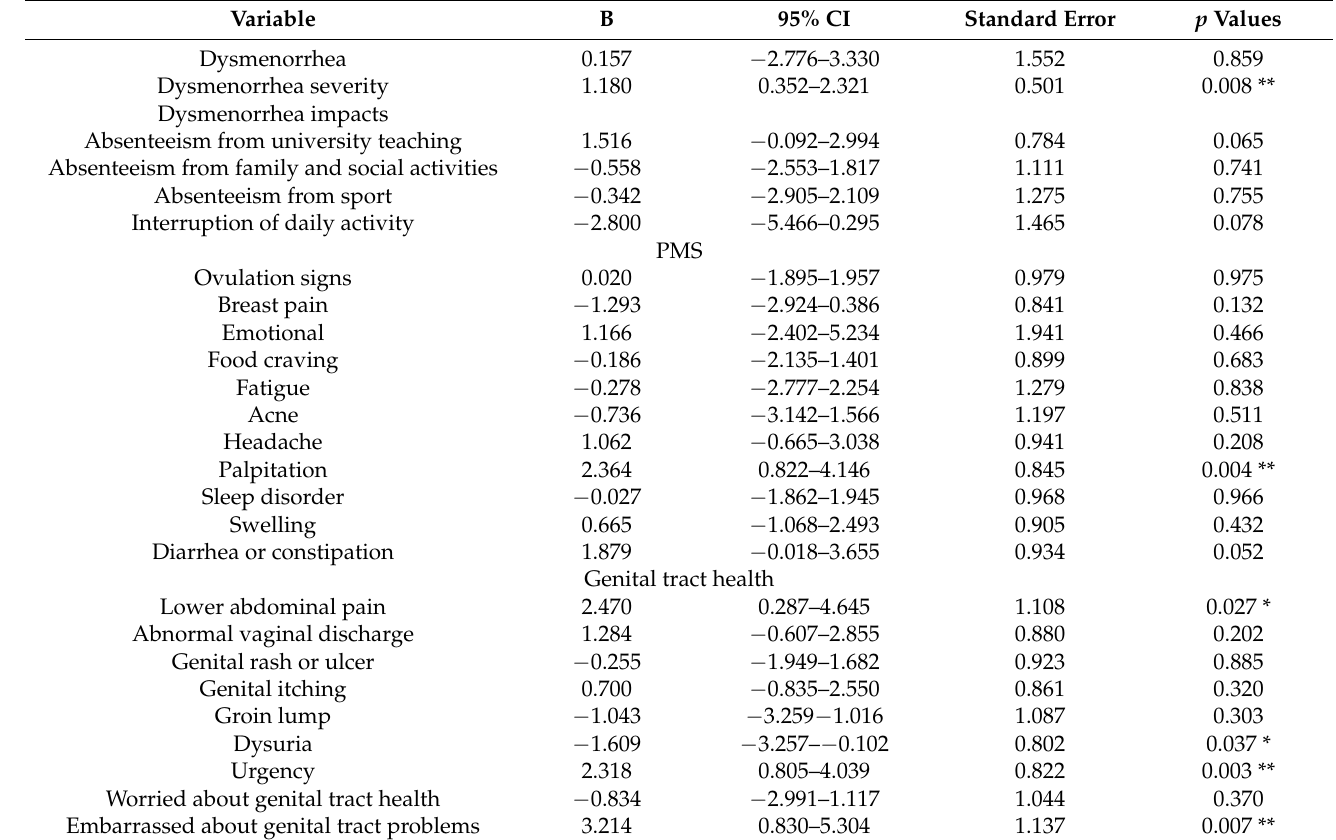
Table 5. Associations between dysmenorrhea, PMS, and genitourinary symptoms during COVID-19 with depression scores using multiple linear regression model.